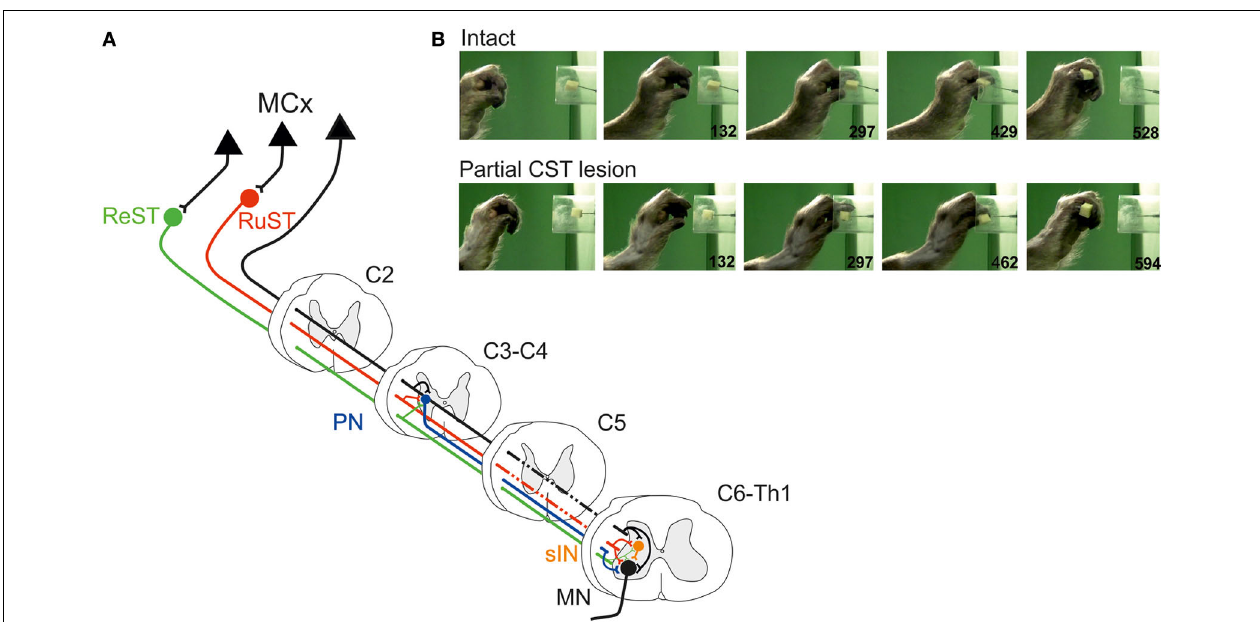
resolution 33ms) in a macaque monkey before and after an incomplete DLF lesion in C4/C5 with remaining CST (and RuST) fibers to the arm/hand